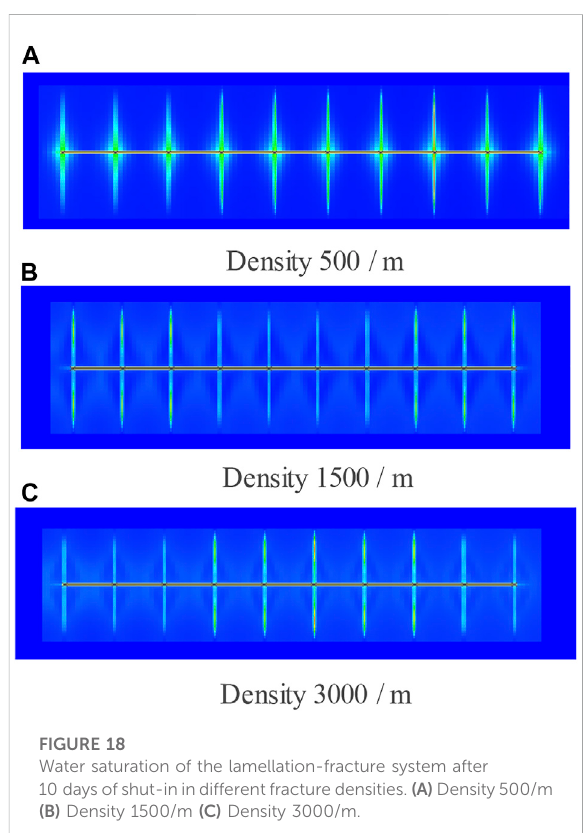
FIGURE 18 Water saturation of the lamellation-fracture system after